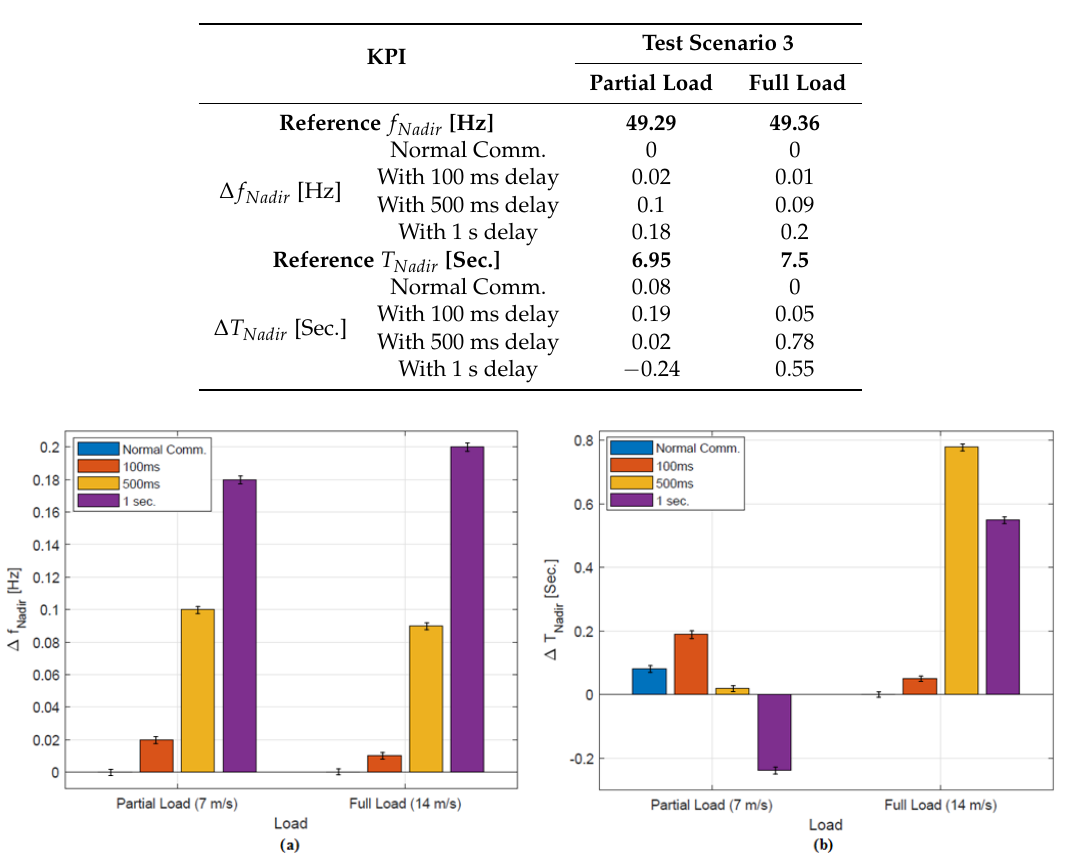
Table 10. Comparison of ( a ) f Nadir and ( b ) T Nadir obtained in Test Scenario -3 with that of Reference Frequency Response.